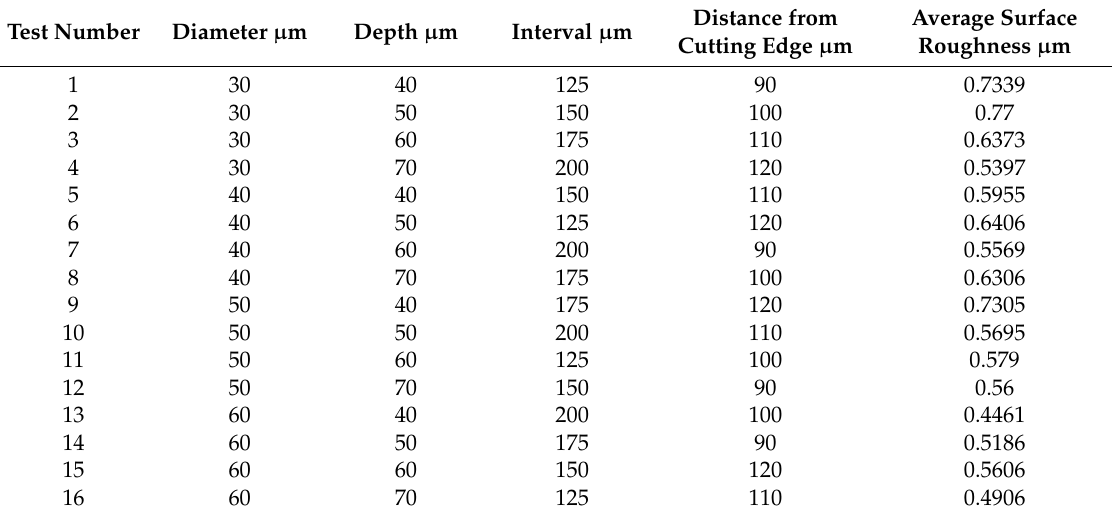
Table 4. Surface roughness test data and test